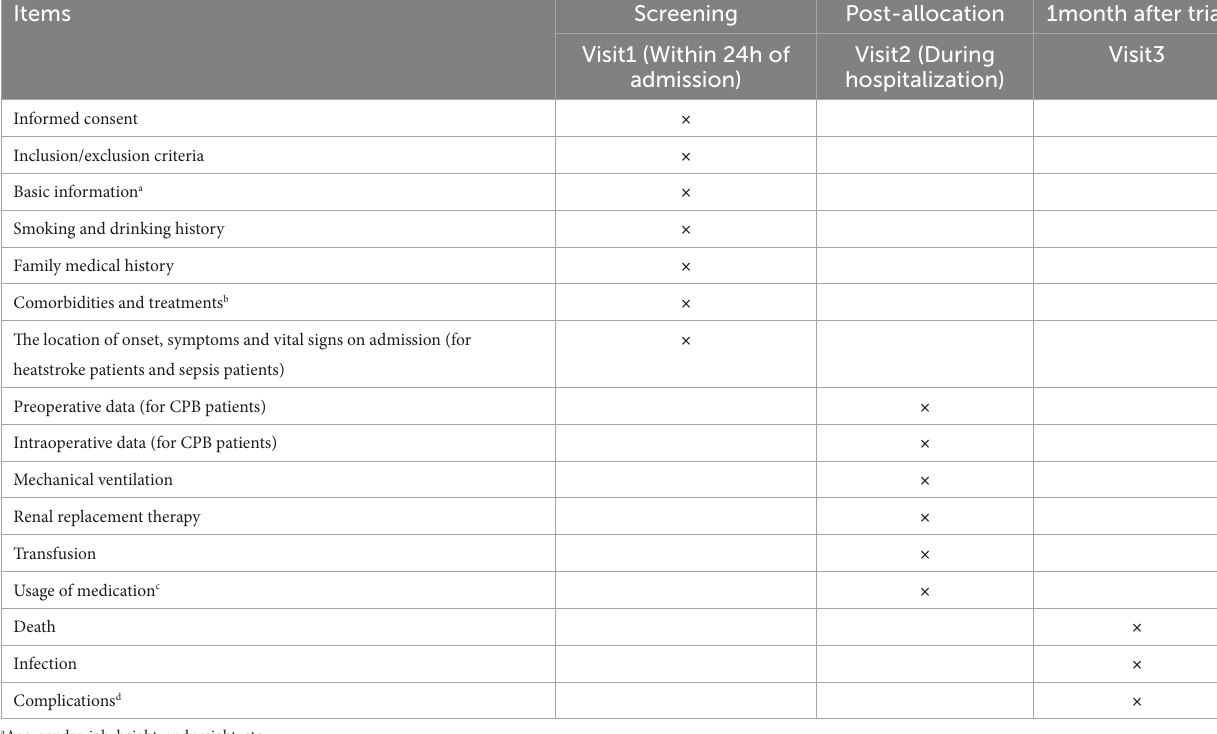
TABLE 2 Schedule of enrollment, intervention, and assessment.